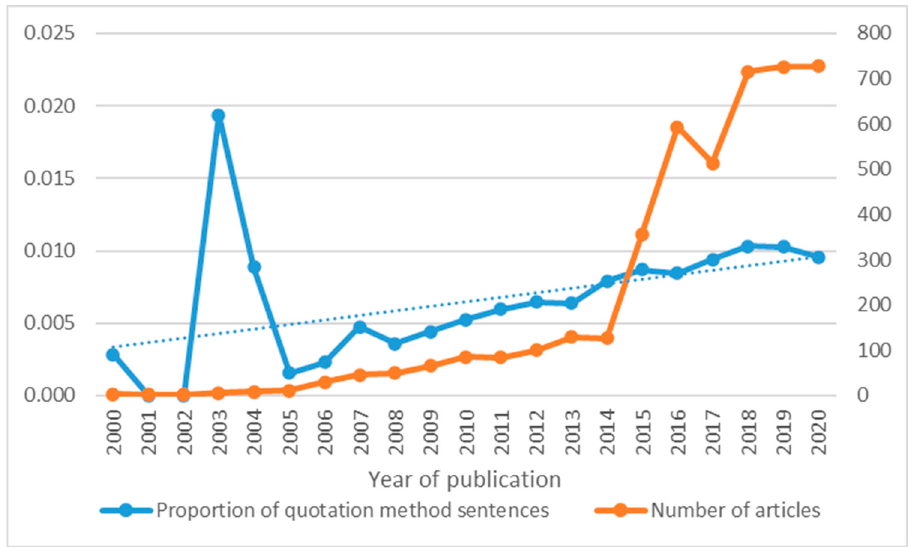
Figure 6. Yearly distribution of quotation method sentences in papers.